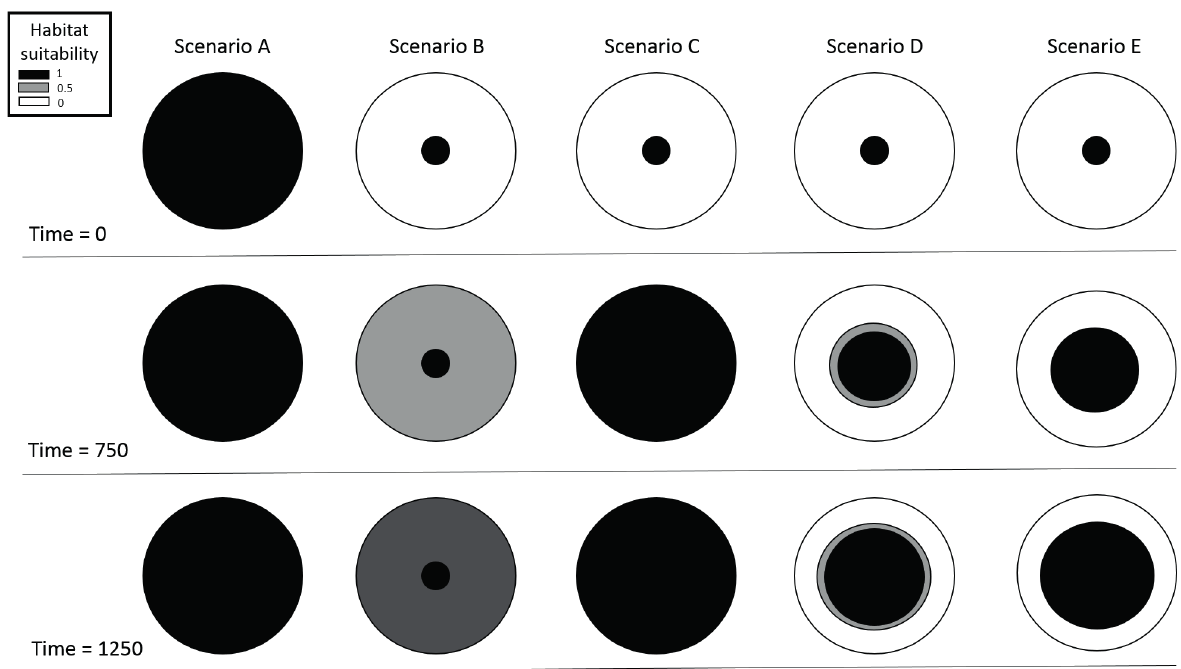
Figure 1 - A scheme of the five simulation scenarios implemented in this study. Scenario A consists in a stable environment (no demographic expansion), whereas the four additional scenarios have different forms of demographic expansion. The total area under habitat restoration may be large (Scenarios B and C), or just a group of adjacent cells (Scenarios D and E). The rate of habitat restoration may be slow and gradual (Scenarios B and D), or instantaneous (Scenarios C and